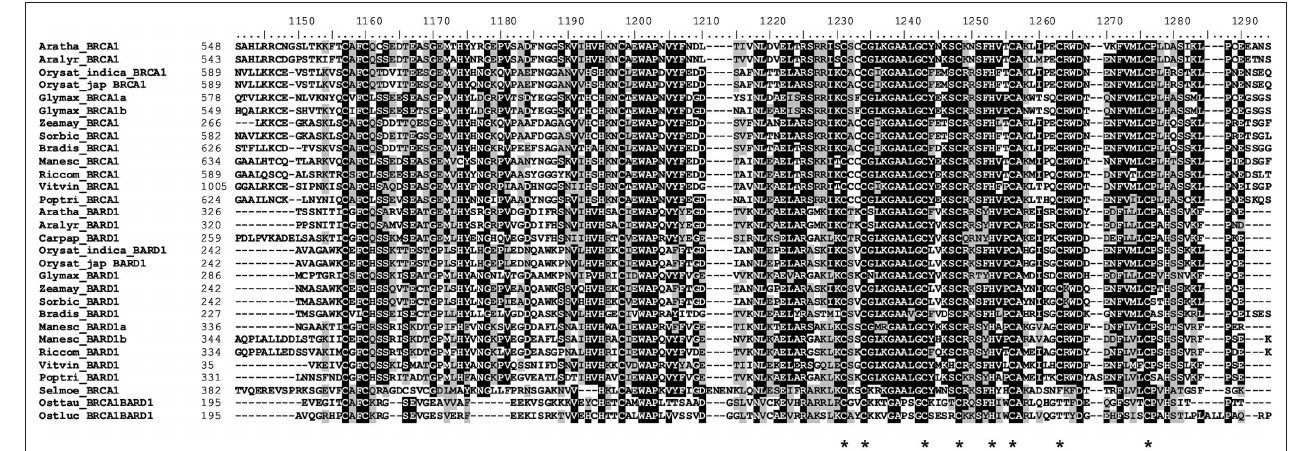
FiguRe 2 | Alignment of the PHD domains and their C-terminal extension. Shown here is an alignment of all the extended PHD domains found in the putative BRCA1 and BARD1 homologs of plants. The C4HC3 motif residues that are typical for PHD fingers are marked with an asterisk. It is clearly visible that the N-terminal area upstream of the typical PHD motif is also highly conserved.